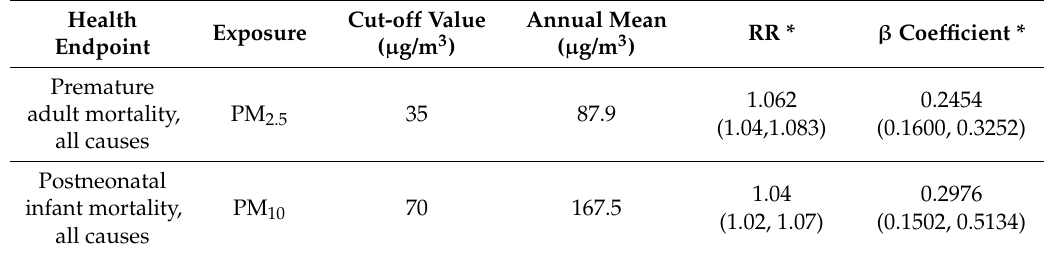
Table 2. Health endpoints used in the AirQ+ model in this